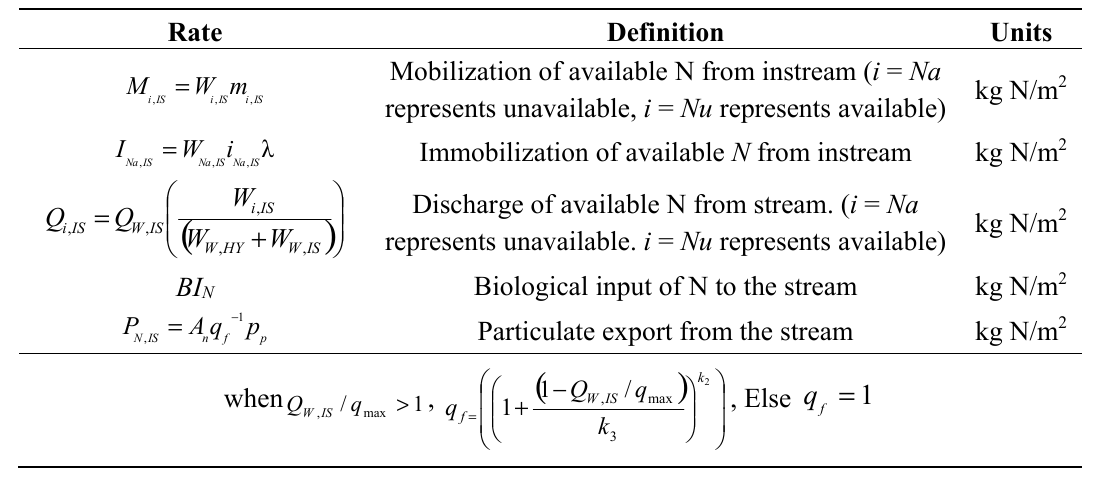
Table 6. Rate terms comprising instream-processing of N. See Table 7 for parameter definitions.